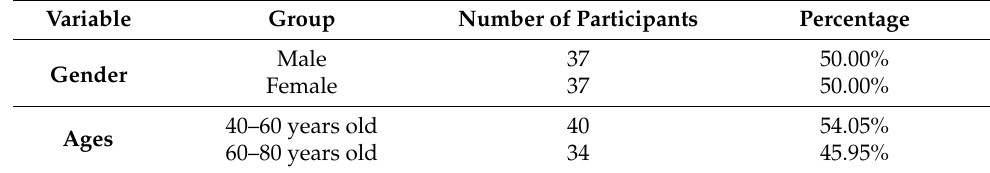
Table 1. Summary of sample characteristics.